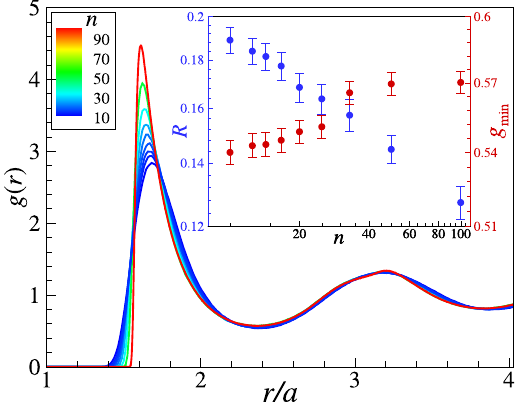
Figure 1. Radial distribution functions, g ( r ), of IPL fluids near the fluid-solid (freezing) phase transition. The curves are color-coded according to the increasing value of the IPL exponent n ( n ~ 10 correspons to blue, n ~ 100 corresponds to red). The inset shows the dependence of the two freezing indicators on the exponent n . The blue symbols (left axis) correspond to the familiar Raveché-Mountain-Streett ratio g g / The red symbols correspond to the value of the RDF at the first non-zero minimum, g later quantity is contained in a very narrow range at freezing of the IPL systems.